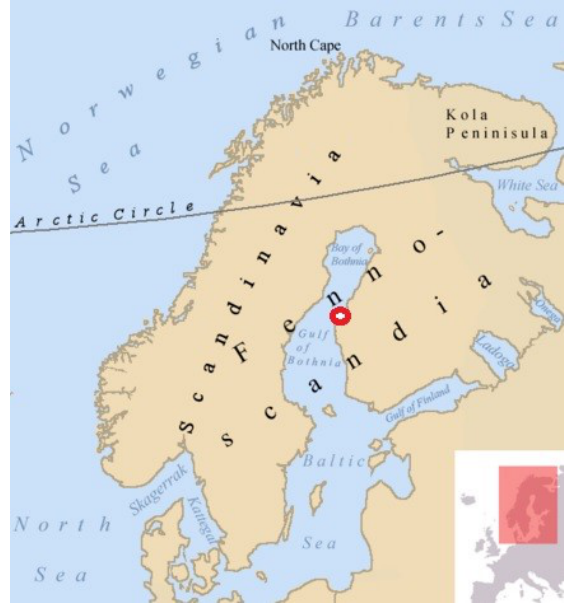
Figure 1. Location of measurement site marked by red circle, Vaasa, Finland